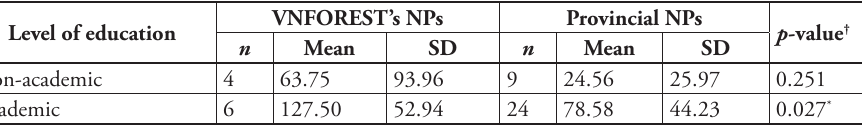
Table 6. National parks staff profile according to the level of